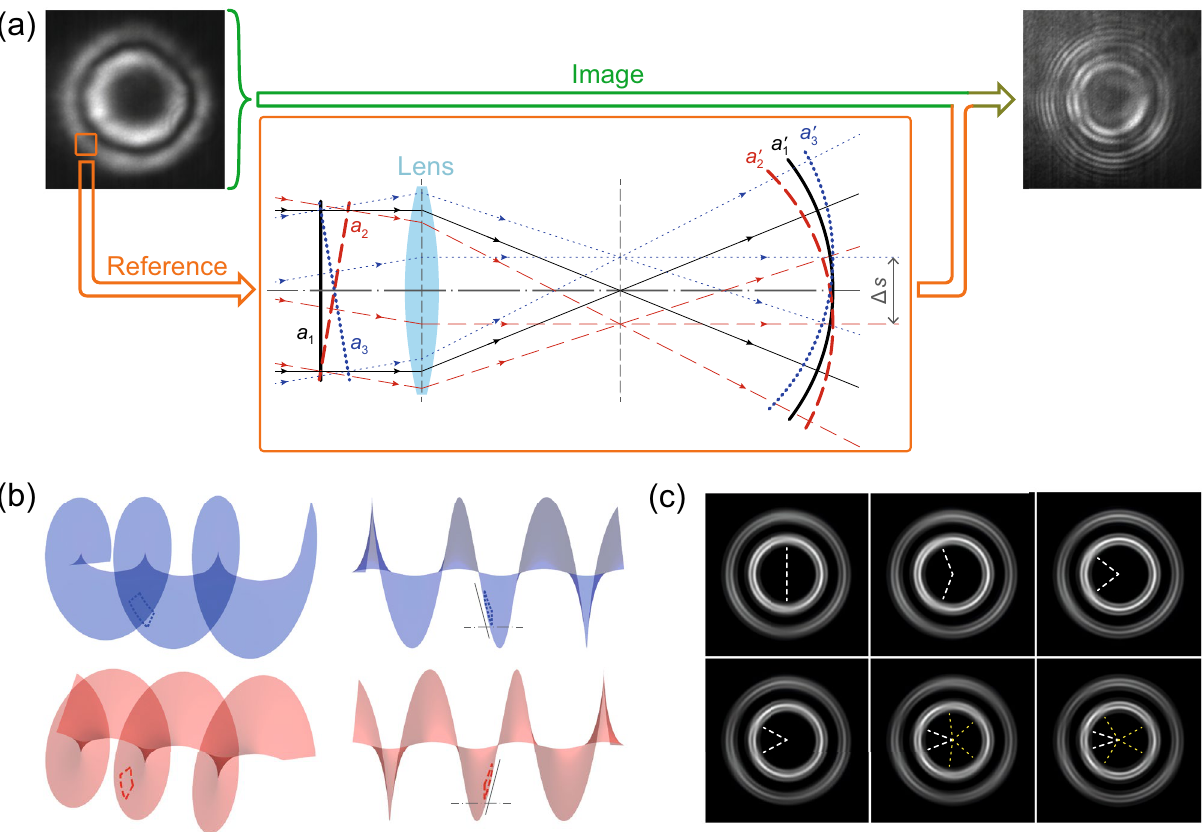
Figure 8. Illustration to the formation of fringe breaks in the interference images for the polariton condensate in the regime of oscillating vorticity. ( a ) Schematic of observation of interference of the condensate PL with a spherical reference wave. The leftmost image is the PL density distribution of the condensate in the micropillar, the rightmost image is the interferometry image obtained from the interference of PL of the condensate with the reference spherical wave. The spherical wave is obtained by transforming a nearly plane wavefront of PL from a small peripheral region of the condensate using a focusing lens, see schematic in the solid orange frame. Inclination of the plane wavefront of the incident wave results in the shift in the lens focal plane of the center of the outgoing spherical wave, cf. wavefronts a 1 , a ′ 1 and a 3 , a ′ 3 shown by red and blue dashed lines, respectively. ( b ) Illustration of the inclination of the nearly flat wavefront, cut from the spiral wavefronts with opposite helicities. (c) Simulated examples of the averaged interferometry images with interference fringe breaks obtained at different shifts (cid:31) s between the centers of the reference spherical waves. Each image represents a superposition of two interferometry images obtained from interference of the condensates of opposite vorticities and spherical waves correspondingly shifted in the image plane. The shift (cid:31) s in the panels increases from left to right and from top to bottom. In the images, the shift is carried out in the vertical direction. Positions of the fringe breaks are indicated by white dashed lines. Yellow dashed lines indicate positions of additional fringe breaks that emerge at large (cid:31) s